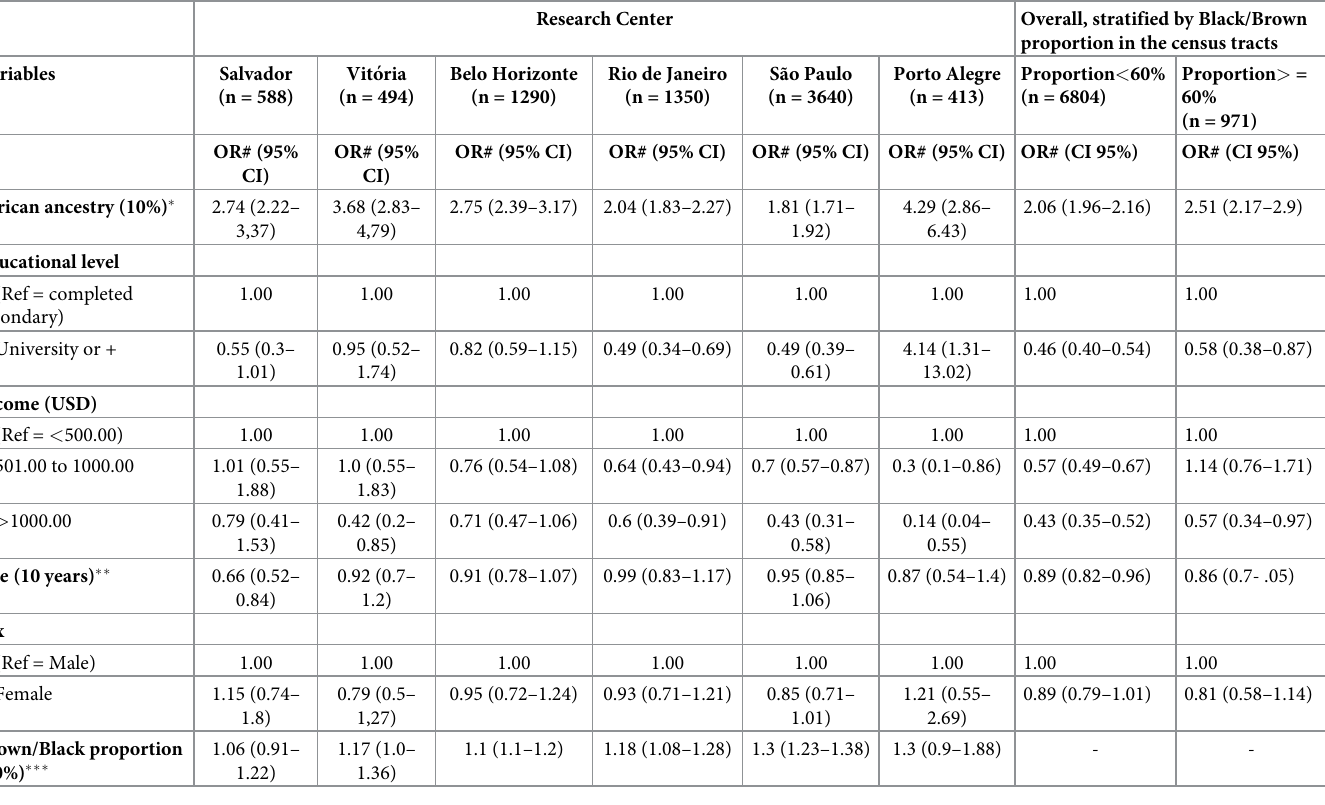
Table 3. Odds ratios of self-declaring as brown (compared to white) according to research centre. ELSA-Brasil,